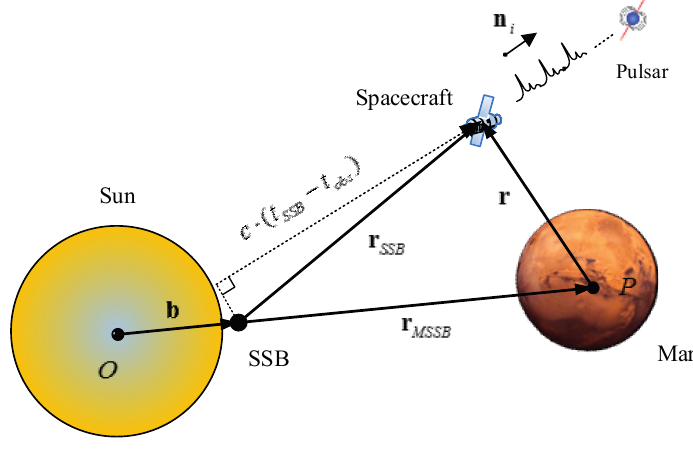
Figure 1. Pulsar timing observation